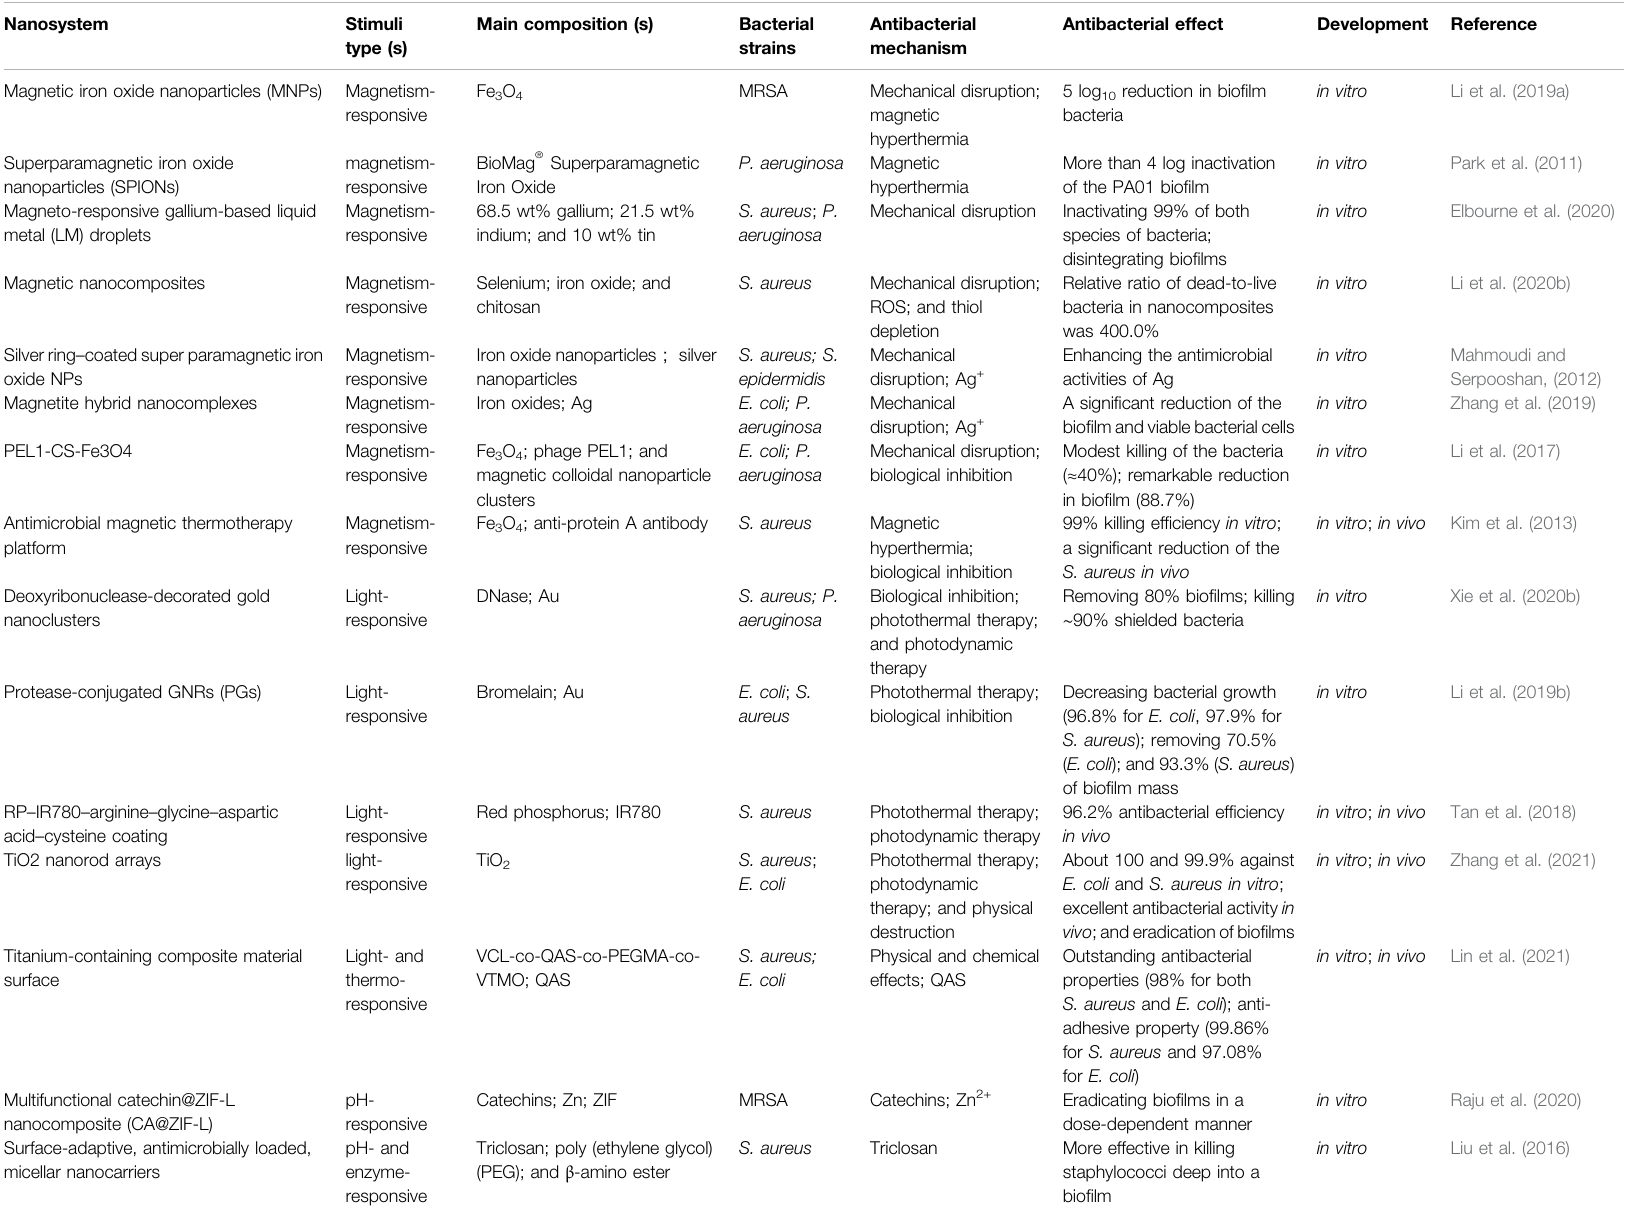
TABLE 1 | Stimuli-responsive nanomaterials with antibacterial